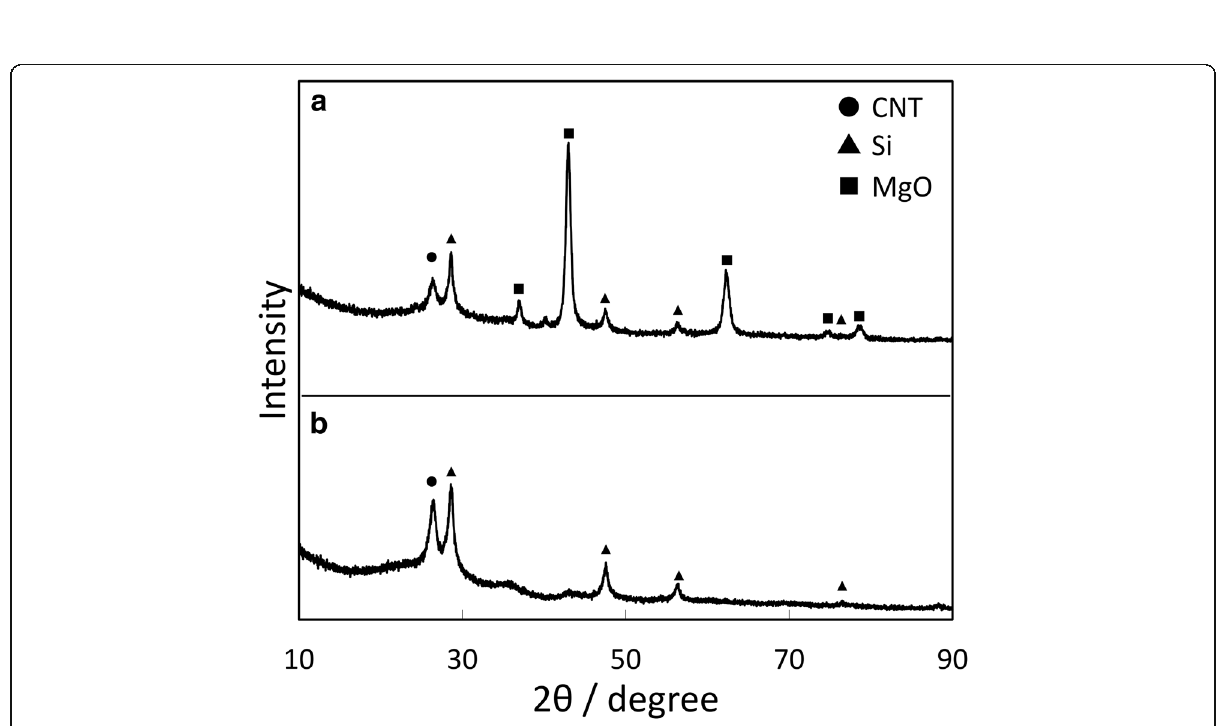
Fig. 2 XRD profile of the composite nanofibers after magnesiothermic reduction ( a ) and subsequent HCl treatment ( b )